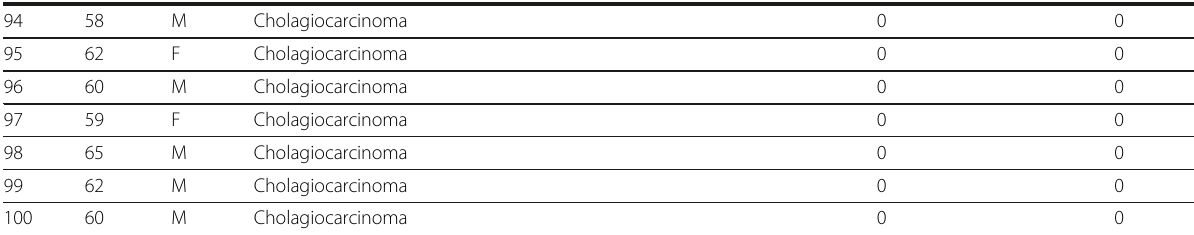
Table 1 Clinicopathological features and the expressions of arginase-1 & HepPar-1 in all studied tumorous cases (no=100) (Continued)